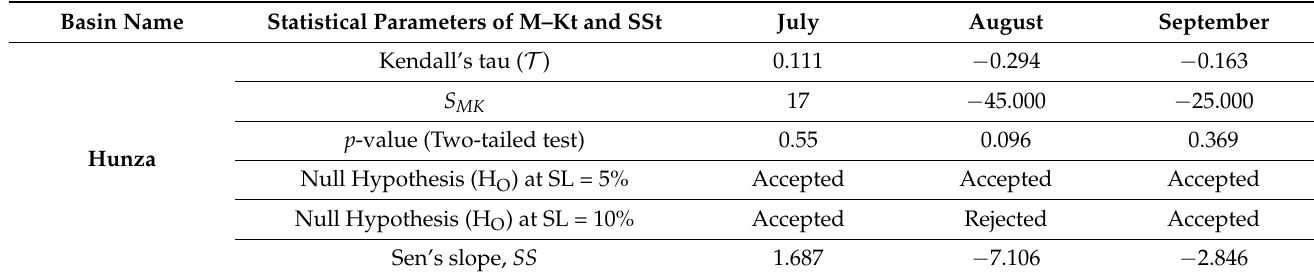
Table 1. Trend analysis results for monthly ELAs of the Hunza River